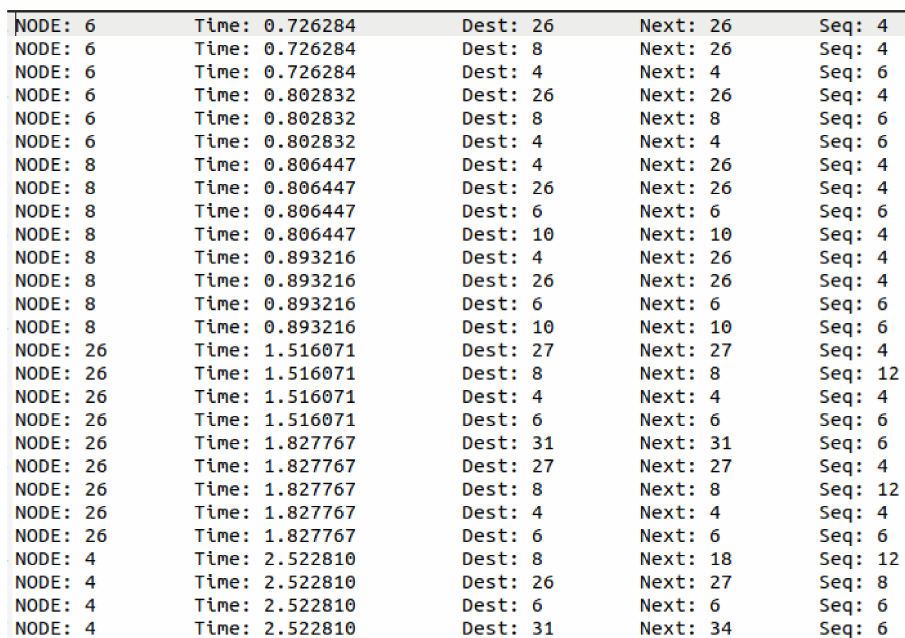
Figure 5. Statistical data from the source node to the destination at the appropriate time.